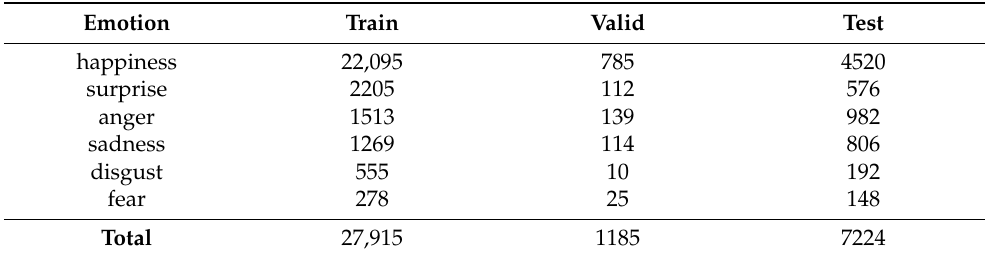
Table 2. Dataset